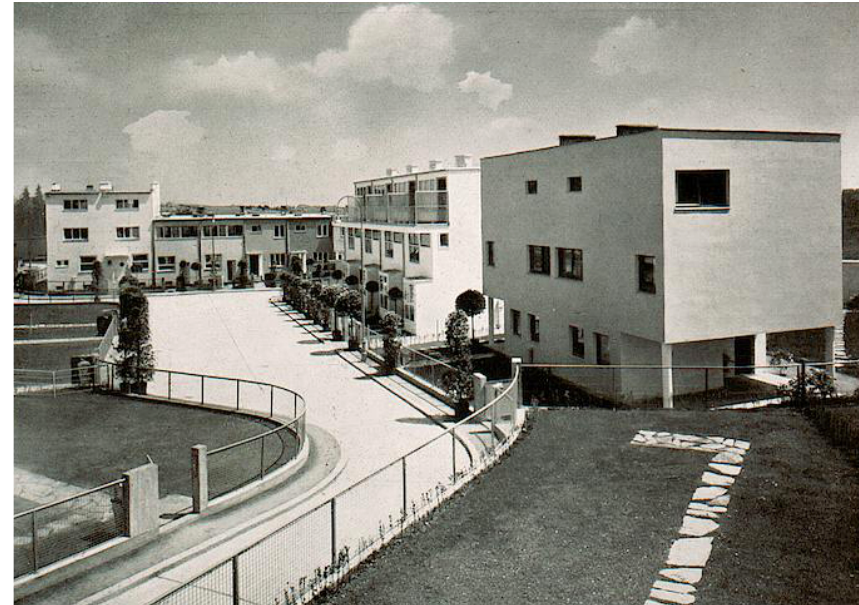
Figure 4. Vienna Werkbundsiedlung, houses numbers 67 and 68, 1932. Source: Innen-Dekoration (1932). Urban Planning, 2019, Volume 4, Issue 3, Pages